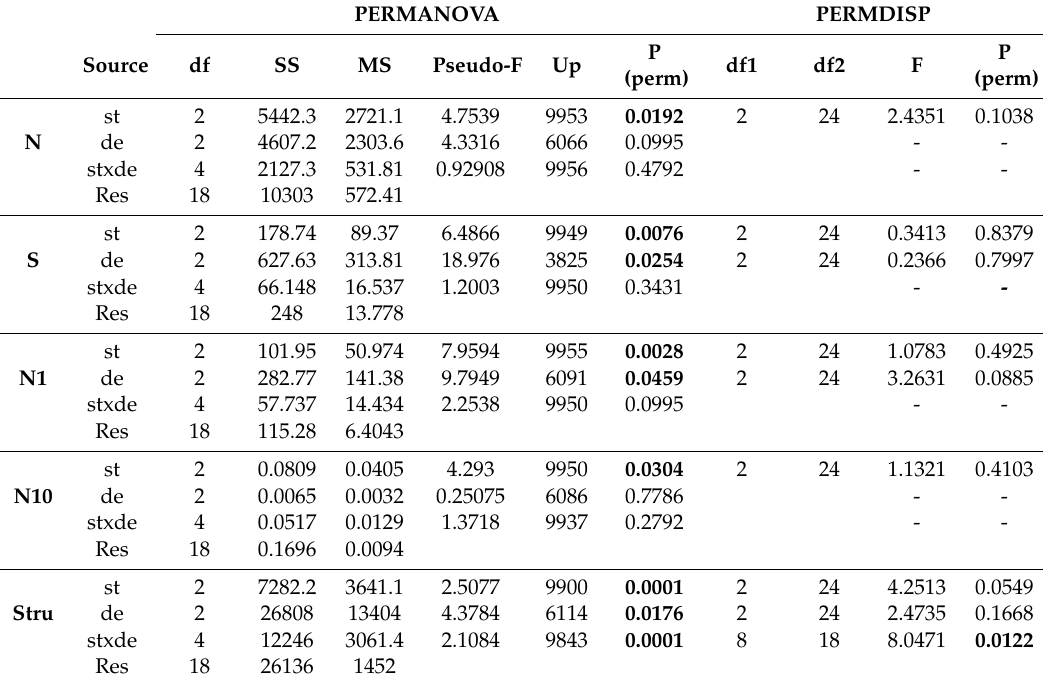
Table 1. Results of PERMANOVA and PERMDISP analyses (untransformed data) testing for di ff erences in abundance (N), species richness (S), Hill’s species diversity index (N1), Hill’s evenness index (N10) and structure (Stru) of polychaete assemblages between stations (st) and depths (de). df, degrees of freedom; SS, sum of squares; MS, mean squares; Up, unique perms; F, F -ratio; P (perm), probability. Significant p -values ( p < 0.05) are given in